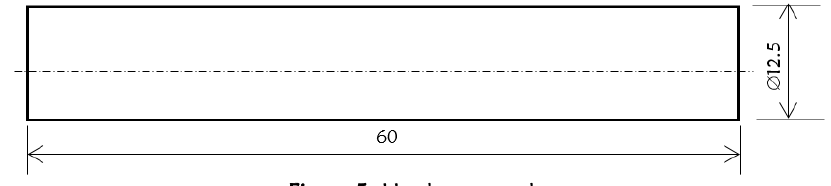
Figure 5: Hardness